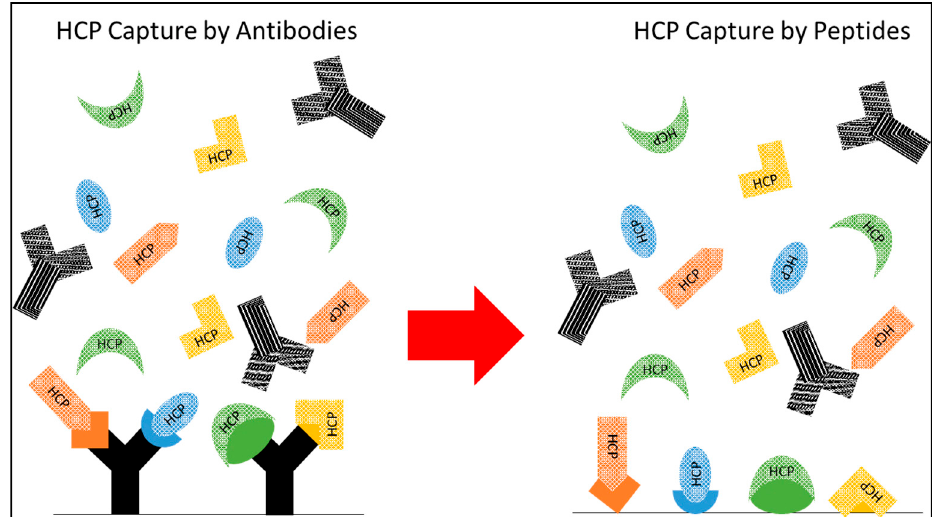
Figure 1. Conceptual diagram of “polyclonal” synthetic HCP-binding resins. Targeted HCP capture is not only possible, but standard practice for HCP quantification using HCP ELISA via polyclonal α -HCP antibodies, as depicted on the left. We propose the generation of a set of diverse ligands to mimic the broad capture of varied HCP species with low binding of IgG, as shown on the right, to allow for targeted capture without the expense and variability introduced by antibody-based ligands.